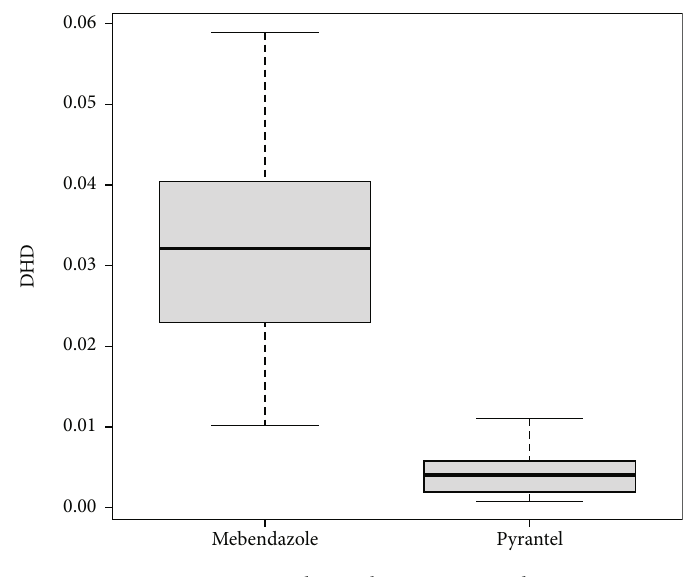
Figure 1: Distribution by active principle. Table 1: Mean values and standard deviations (in italics) of the de fi ned daily dose per 1000 inhabitants and day (DHD) by active principle and province (2016 –